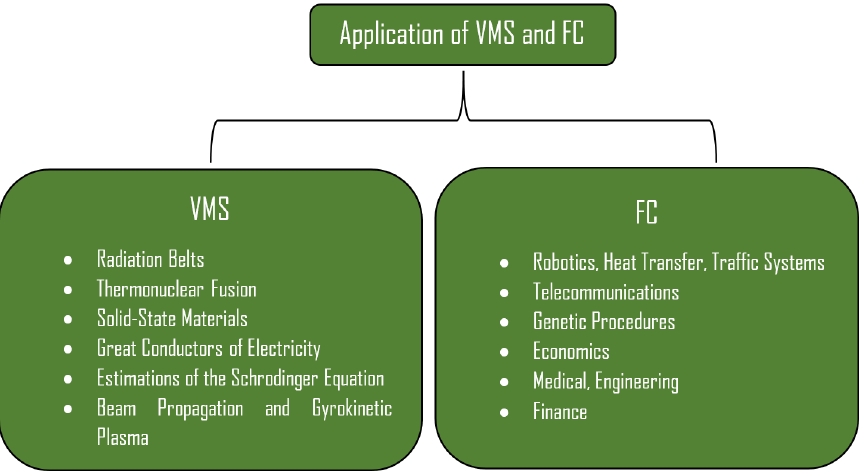
Figure 1. Applications of VMS and FC.